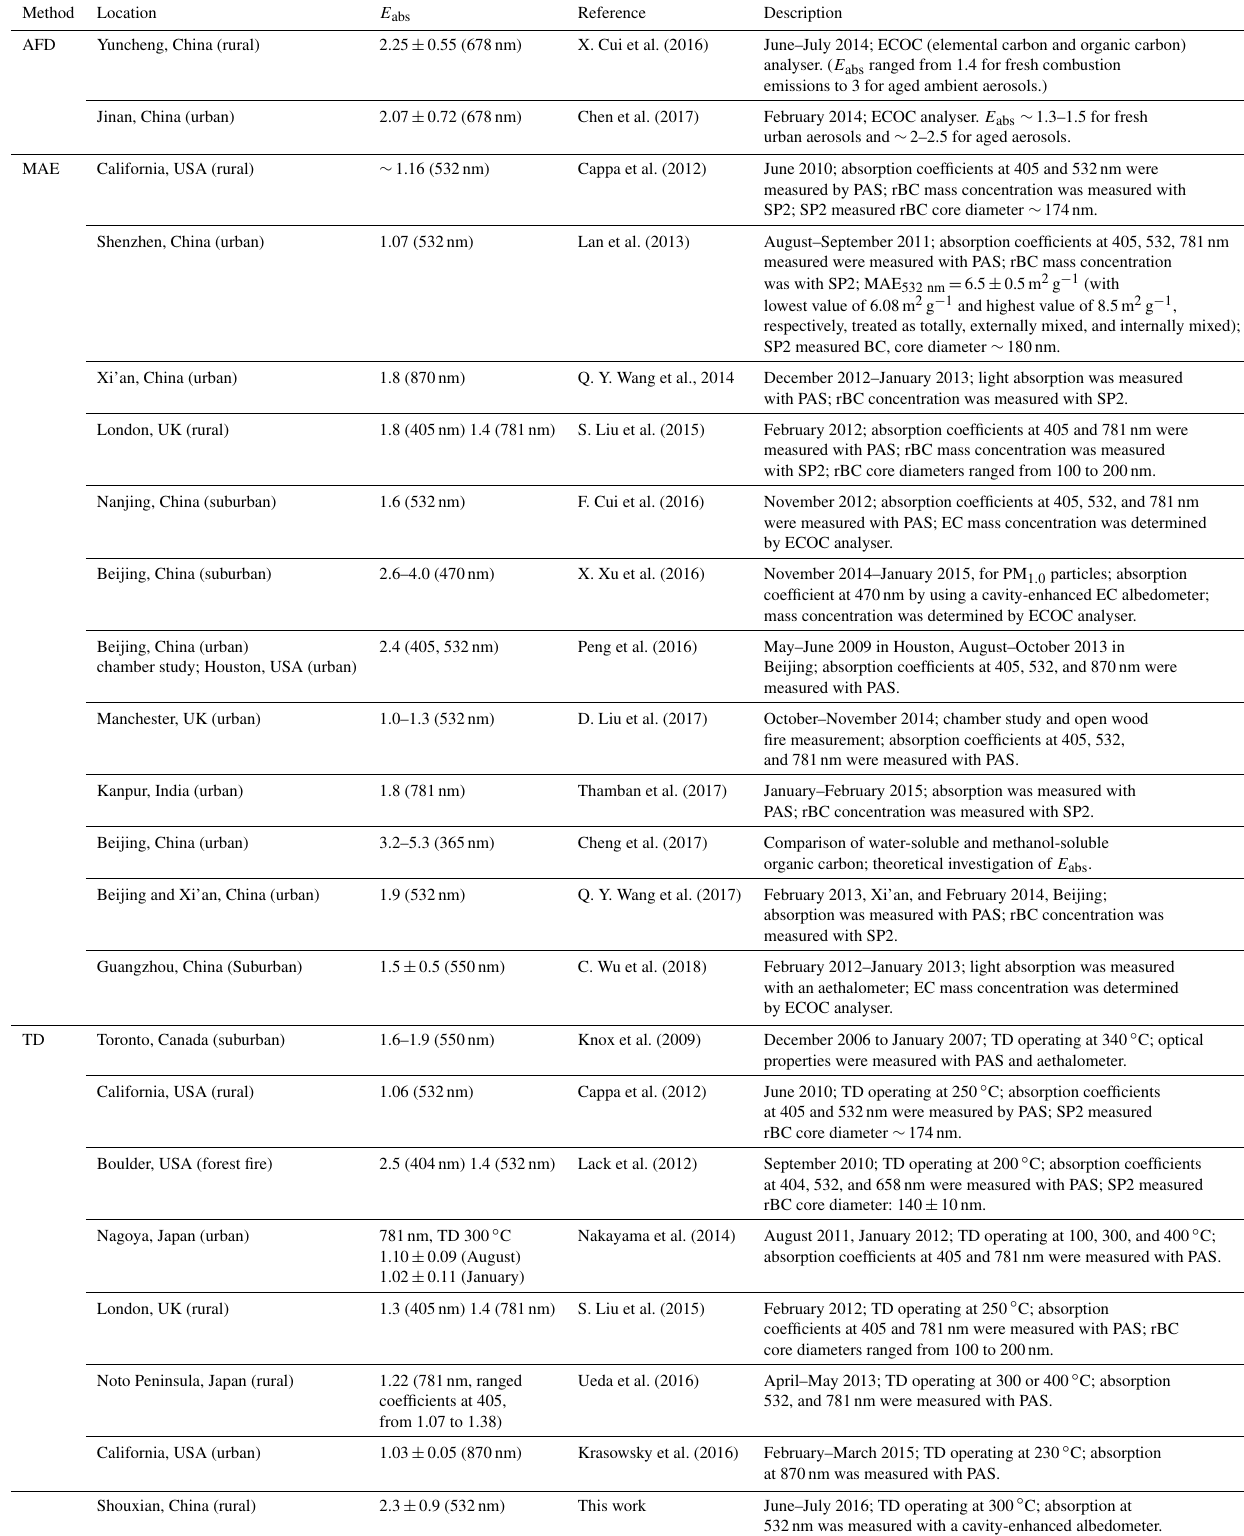
Table 1. A survey of some field measured E abs values. Method